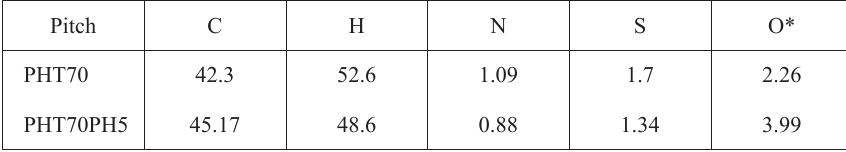
Table 9. Elemental analysis of the pitches Pitch C H N